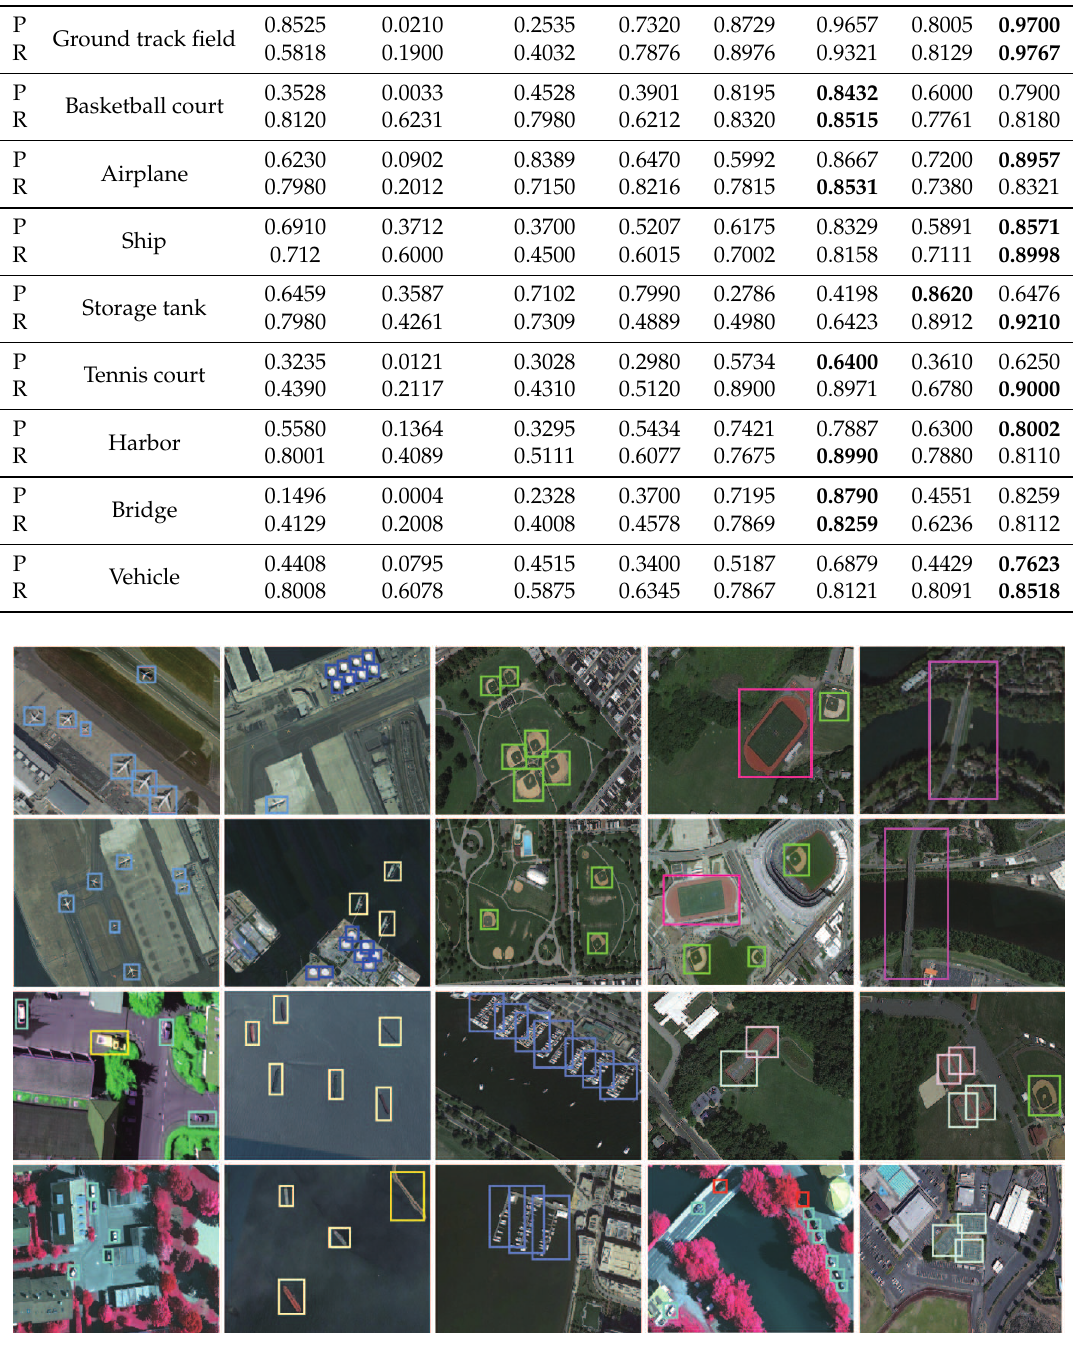
Figure 7. Some visual detection results with MsRi-CCF; false positive samples are marked in yellow and true positives are in the other